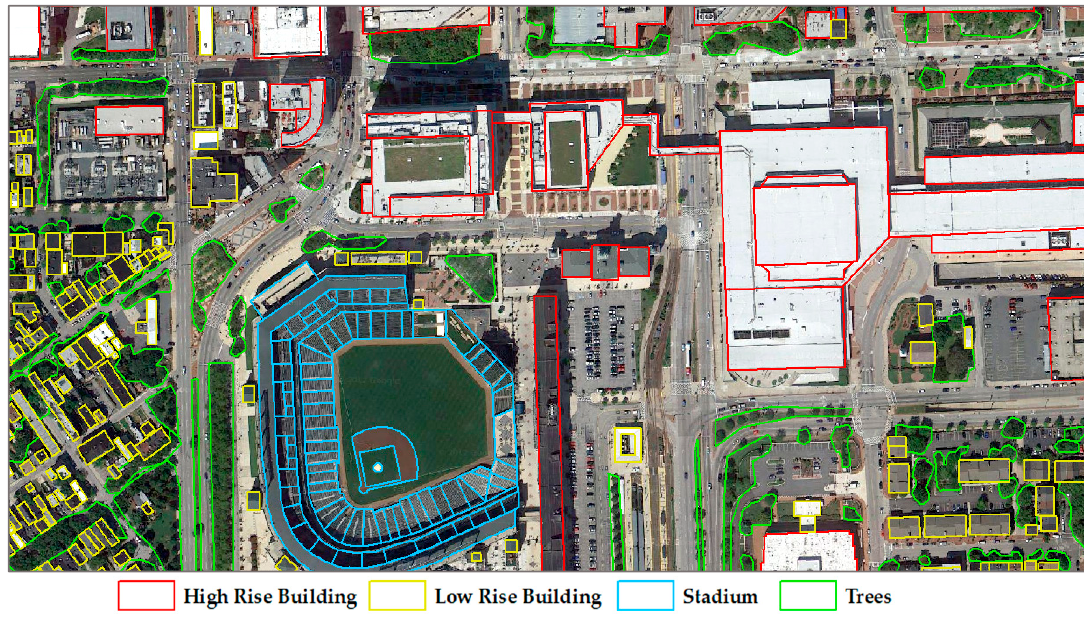
Figure 6. Remote sensing image and reference data.